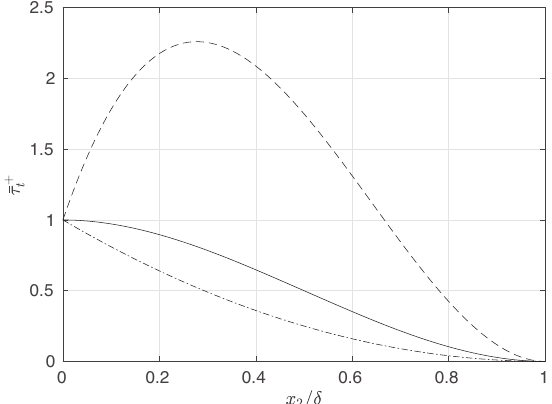
Figure 1. Pro fi les of (cid:1) s þ t for ( – – – ) b P = 10, ( —– ) b P = 0 and ( – (cid:8) – (cid:8) ) b P = (cid:2)